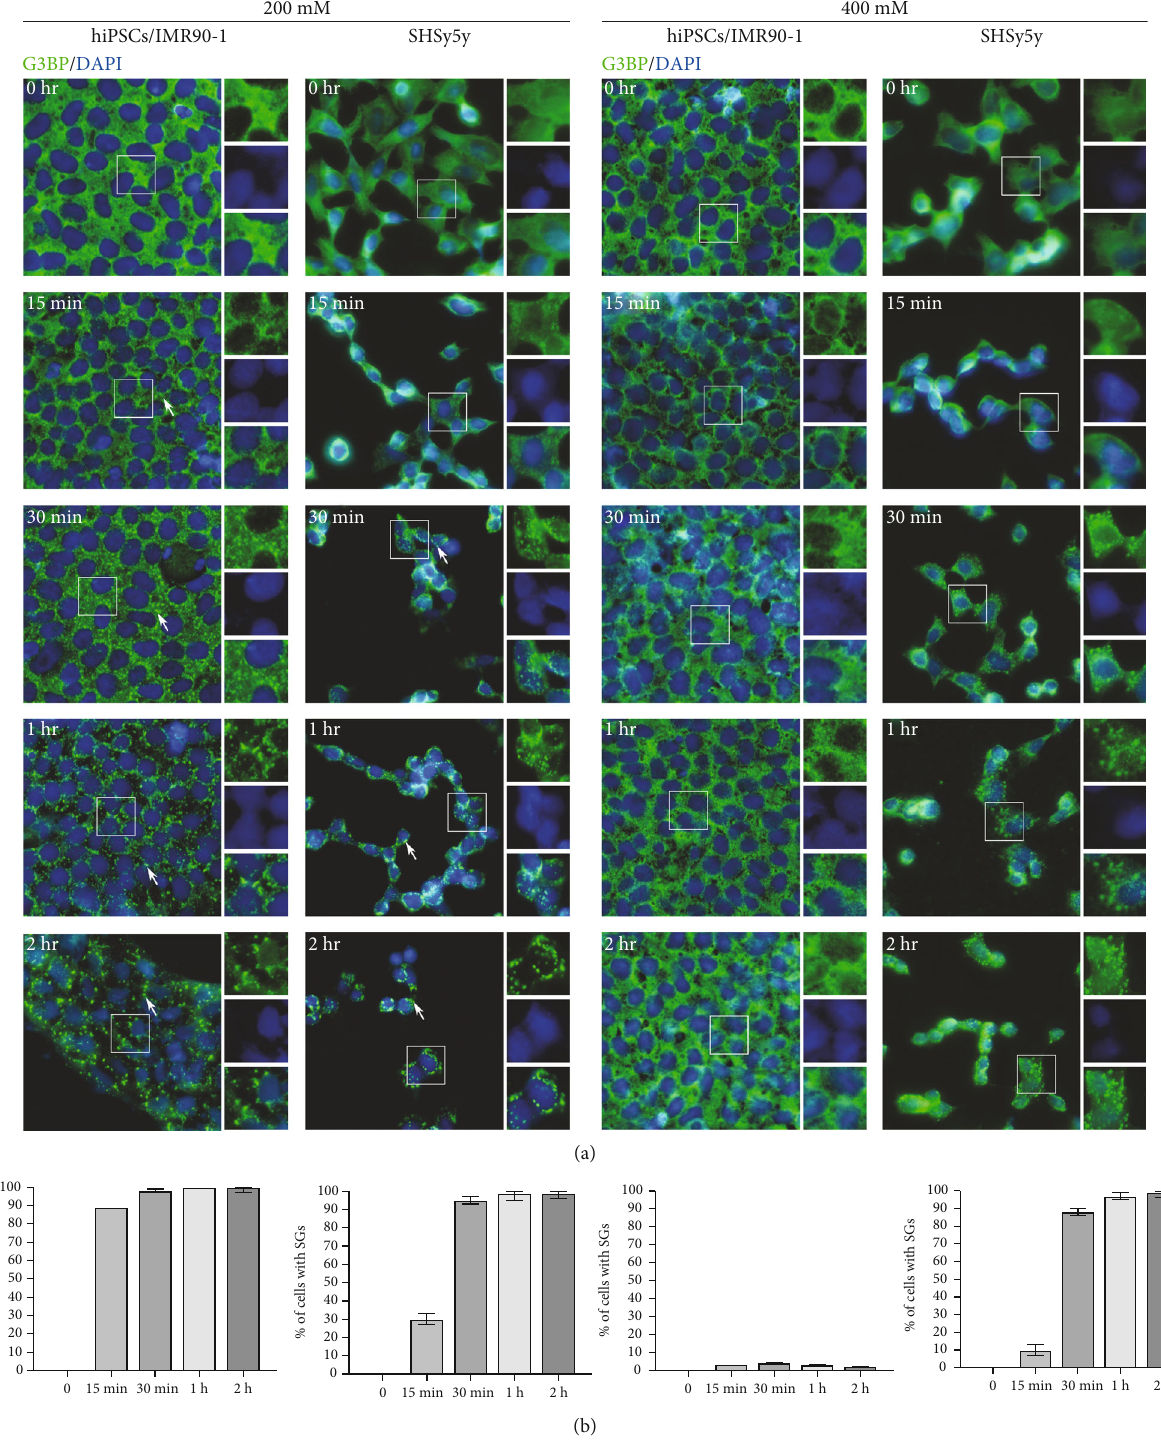
Figure 2: Time-course experiments to ensure that SG assembly in hiPSCs/IMR90-1 and SH-SY5Y is time independent. (a) Representative fl uorescence microscopy images showing IMR90-1/hiPSCs and SH-SY5Y treated with 200 and 400mM of sodium chloride stained with the robust SG marker (G3BP (green)). Nucleus is stained in blue (Hoechst). Insets show magni fi ed views of SGs. White arrows indicate SGs. Scale bar indicates 20 μ m. (b) Percentage of hiPSCs/IMR90-1 with G3BP-positive SGs during the time-course treatment with the indicated concentrations of sodium chloride (0, 200, and 400mM). The average percentage of cells with SGs is shown. Error bars indicate the ± standard deviation from 3 independent experiments. Approximately, 1000 cells were counted (distributed over 20 di ff erent fi elds within each